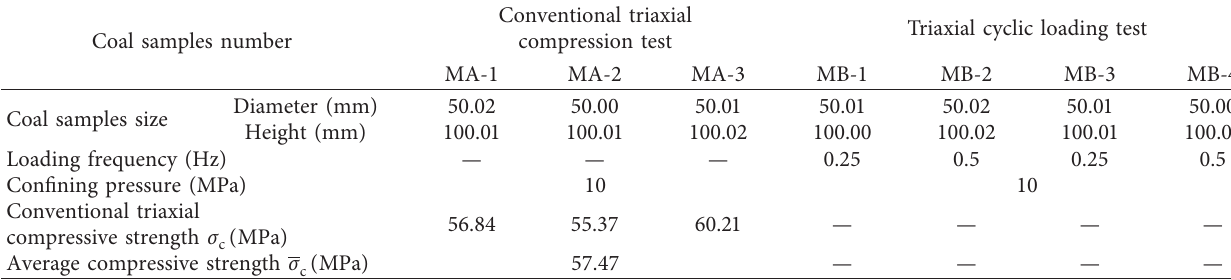
Table 1: Coal sample size and test